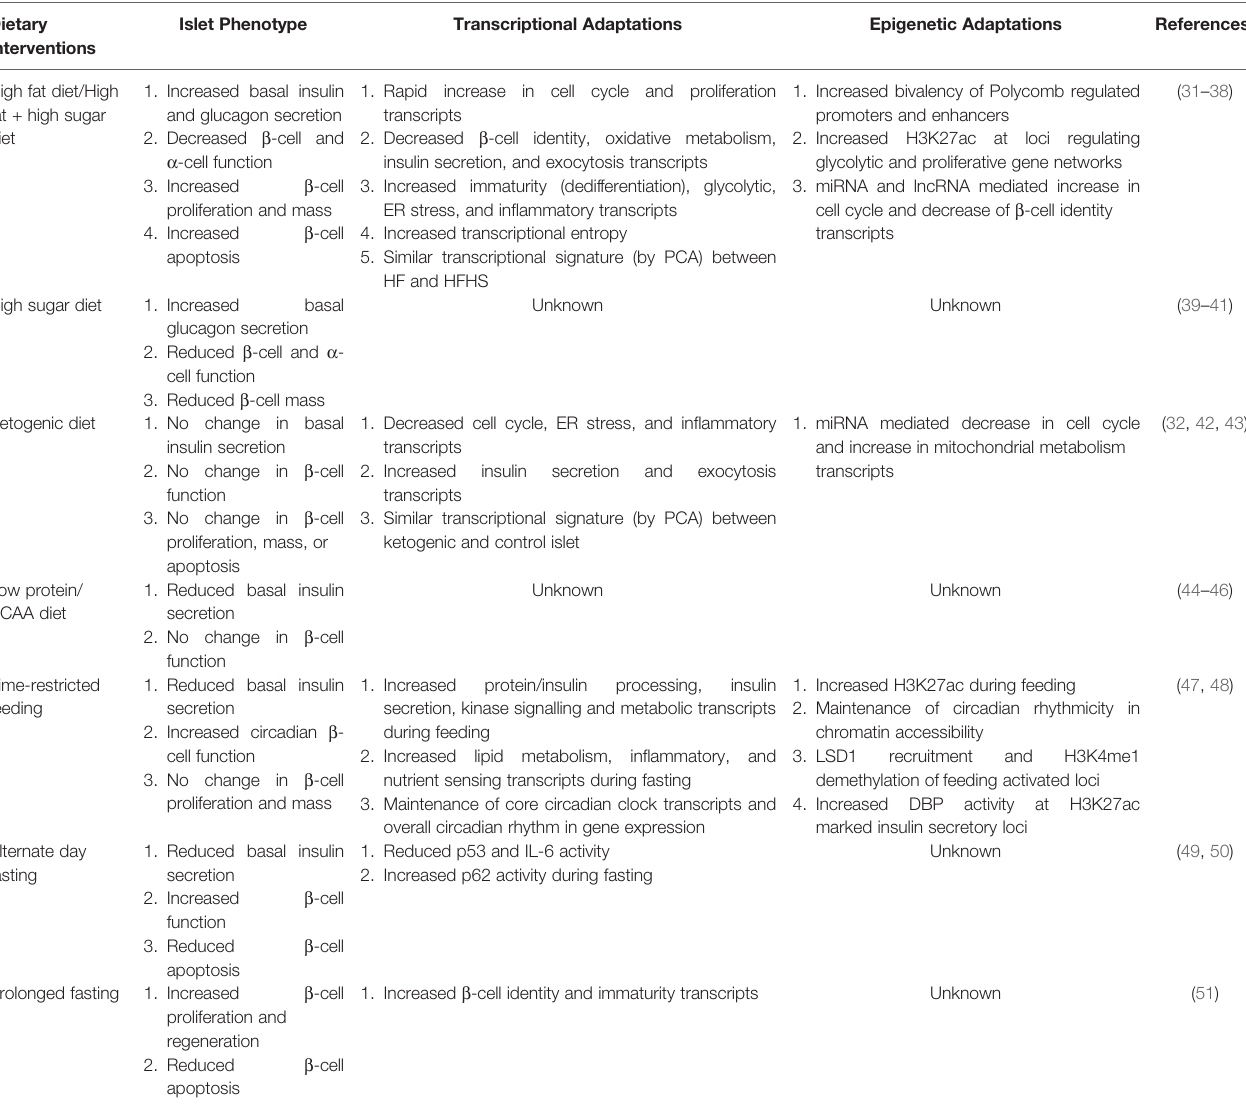
TABLE 1 | Overview and comparison of the islet ’ s physiological, transcriptional, and epigenetic response to dietary